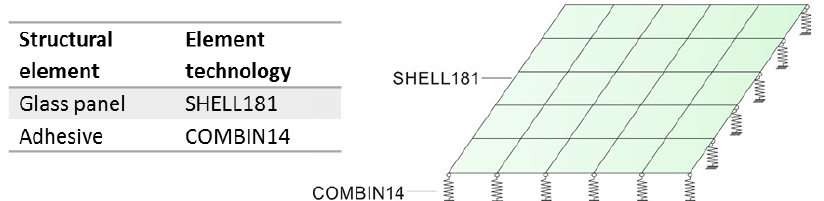
Fig. 14 Simplified numerical model using spring